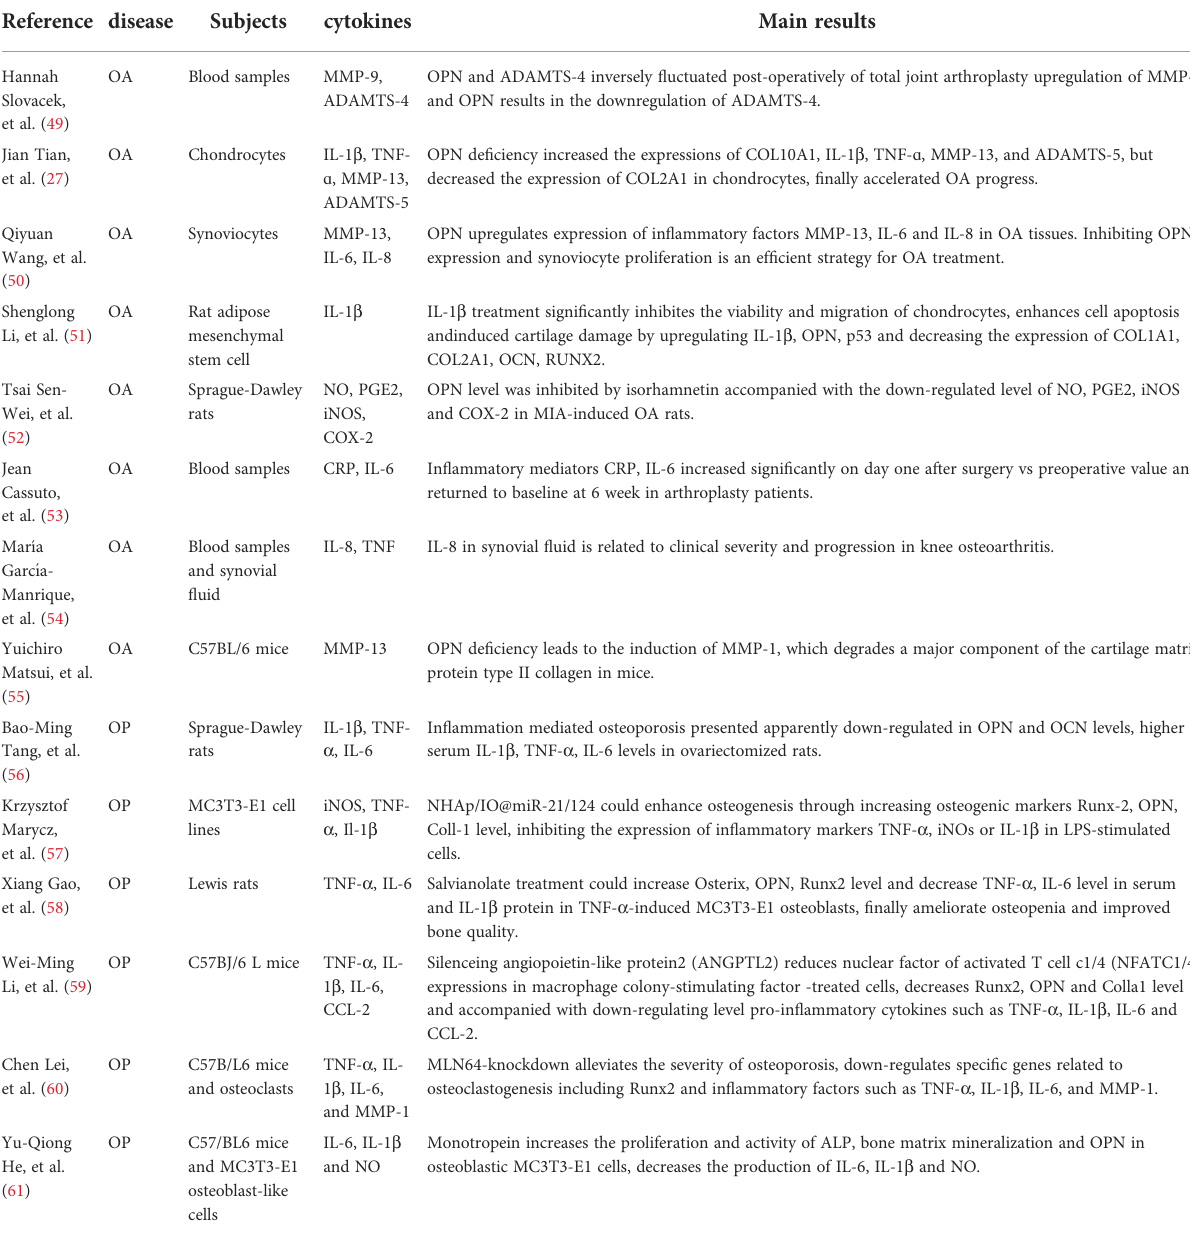
Table 1 OPN involves in fl ammation activity in OA and OP. Reference